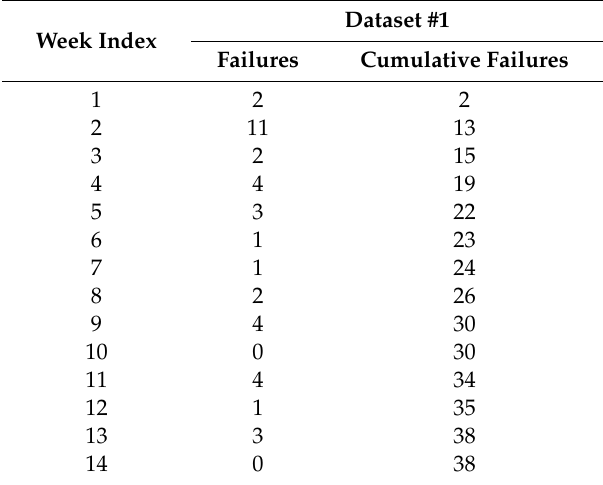
Table 2. Failure data-dataset